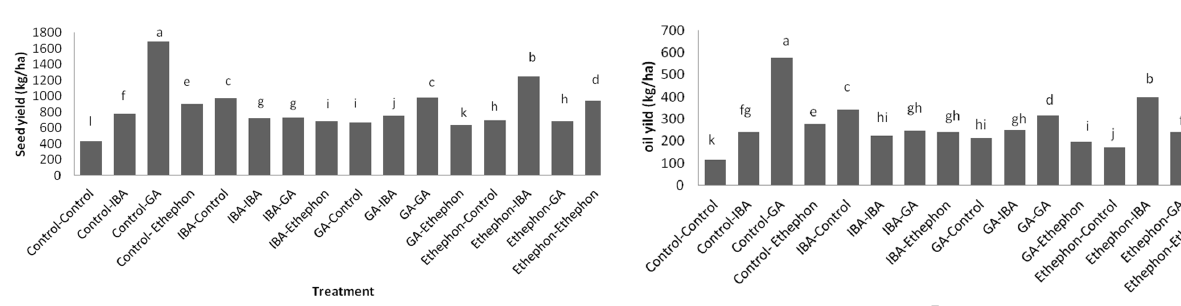
Fig. 4. Effect of PGRs on seed yield kg/ha in medicinal pumpkin ( Cucurbita pepo var . styriaca cv. ‘Kaki’) in trellis method